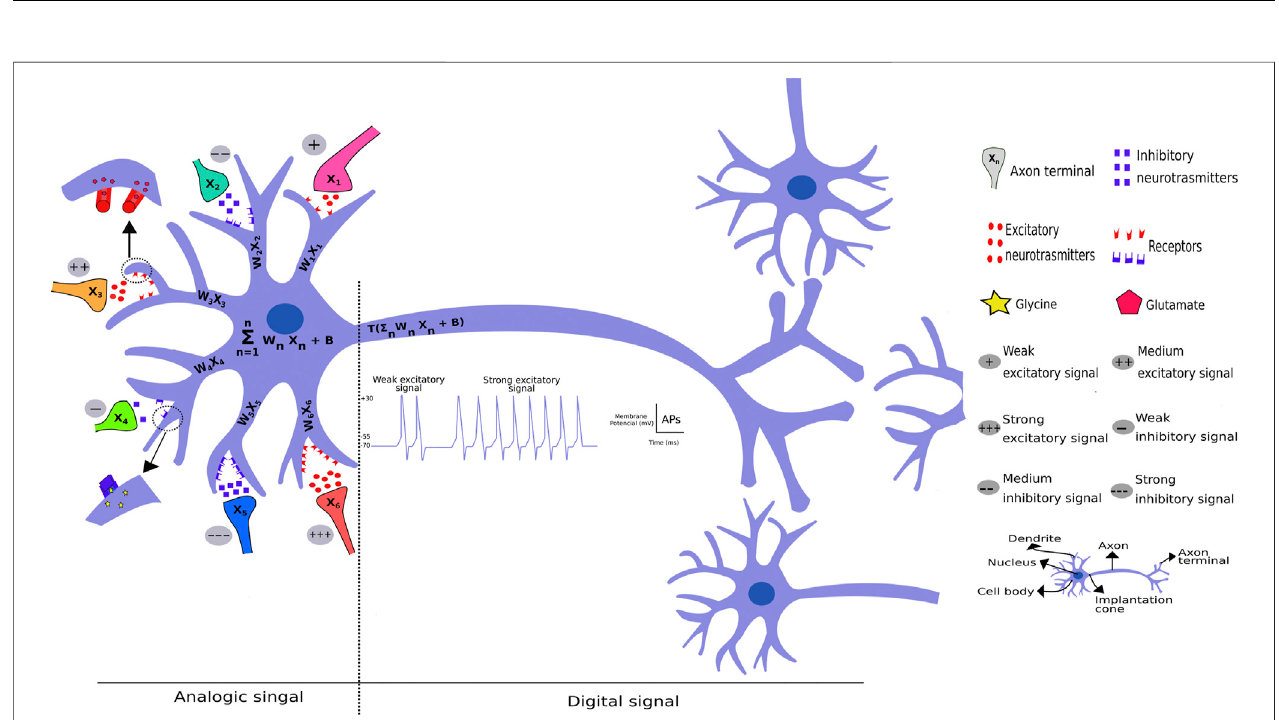
FIGURE 3 | Comparative model of perceptron and real neuron. A neuron receives both excitatory and inhibitory signals through the release of different neurotransmittersfromdifferentbiologicalneuralnetworksthatgeneratespostsynapticexcitatoryorinhibitorypotentials.Thesepotentialscanaddupwithspaceortime inacontinuousmanner,thusclassi fi edasanalogicsignals.Ifthisvoltagereachesthepotentialthreshold,itwilltriggeranAPintheaxonimplantationcone(hillock),which will lead to the passage of the signal through the axon and the axon terminals until it synapses with other neurons. This type of signal can be classi fi ed as digital, because it occurs (binary 1) or not occurs (binary 0), depending on the signal reaching the action potential threshold.